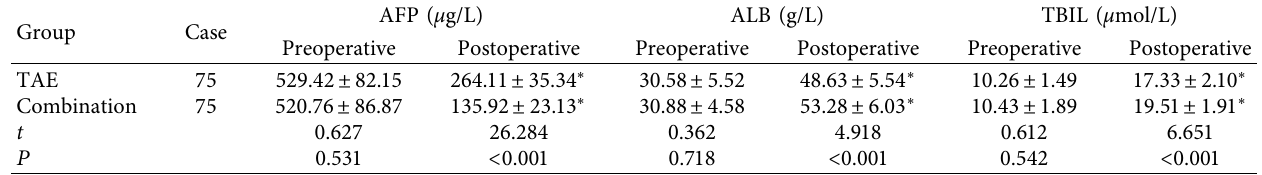
Figure 2: Level distribution of postoperative liver function-related indicators in the two groups. (a) Level distribution of postoperative liver function-related indicators in the TAE group; (b) levels of postoperative liver function-related indicators in the combination group. Table 3: Comparison of liver function indicators between the two groups ( x ± s ).